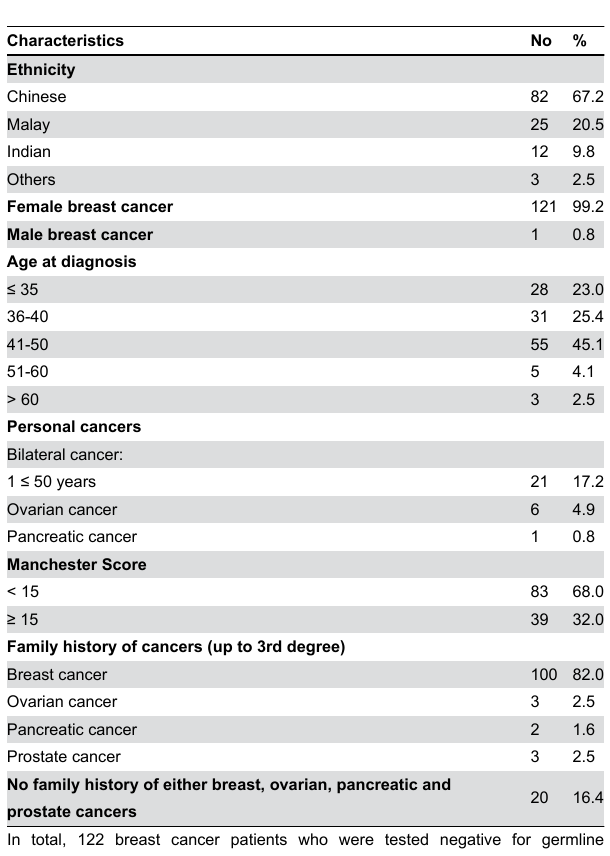
Table 1. Characteristics of 122 individuals tested for PALB2 germline